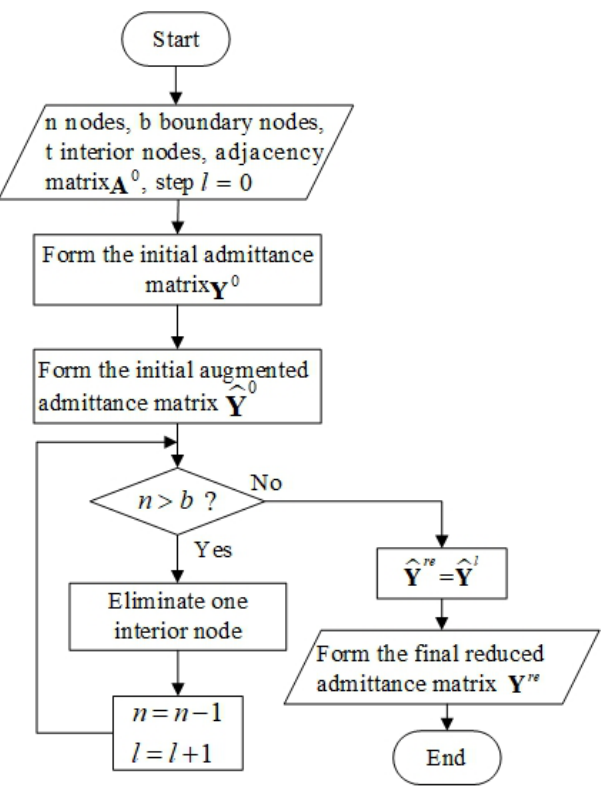
Figure 5. The flow chart of the proposed Kron reduction.